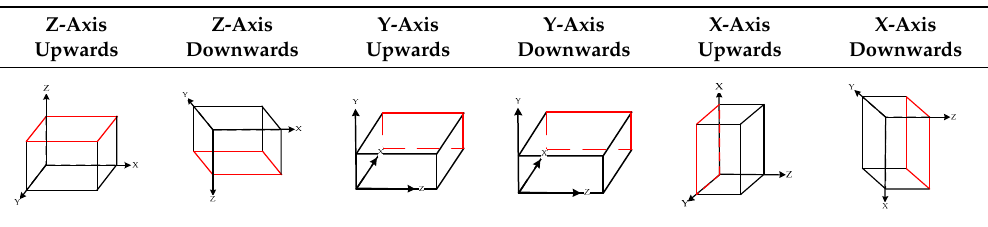
Table 2. Six-sided calibration method.